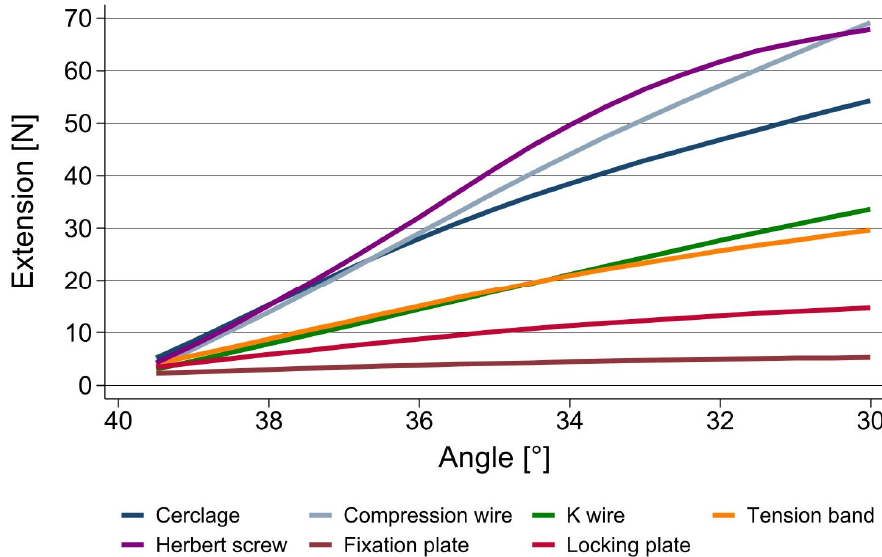
Figure 2. Stability of different fusion techniques for PIP joint arthrodeses in extension.